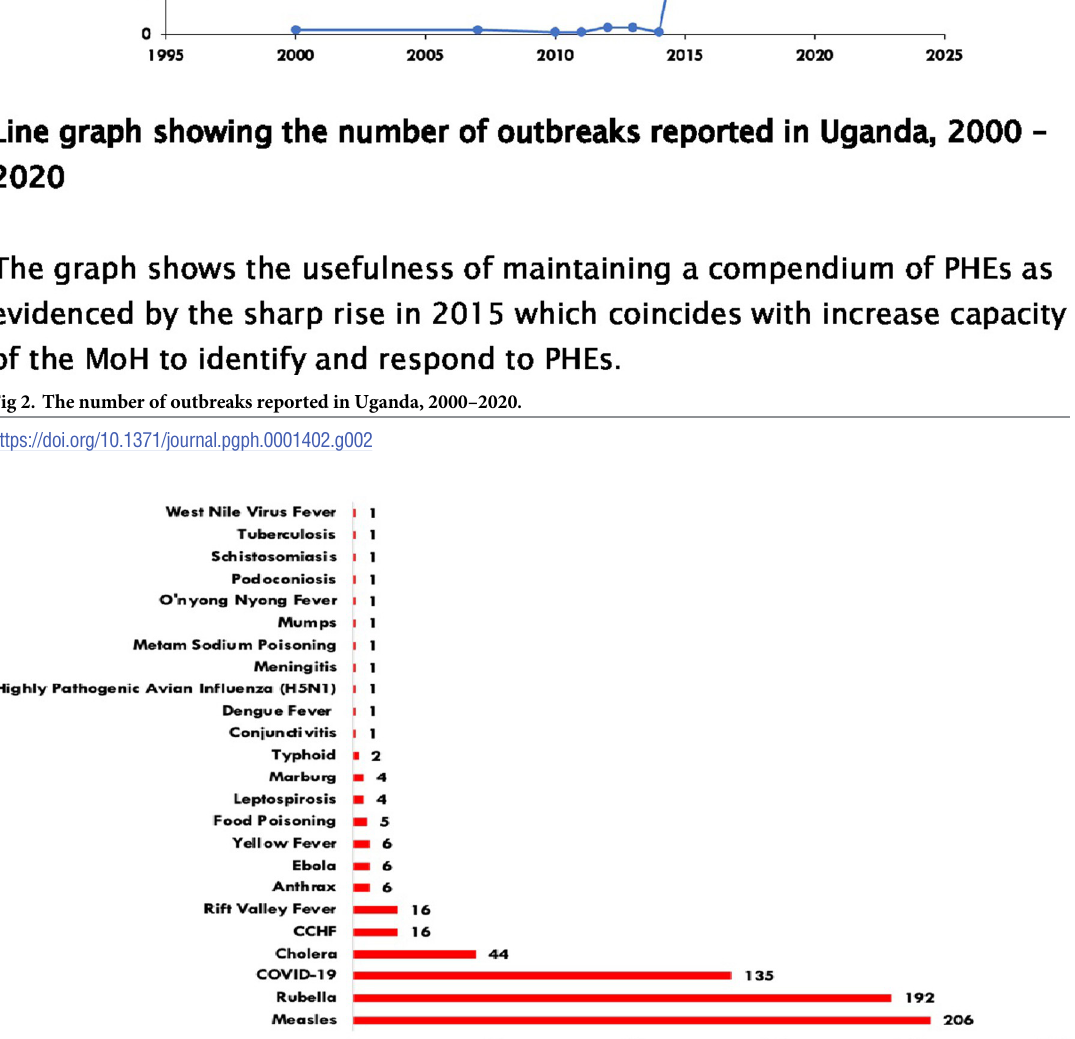
Fig 3. Frequency of reported outbreaks in Uganda, 2000–2020.